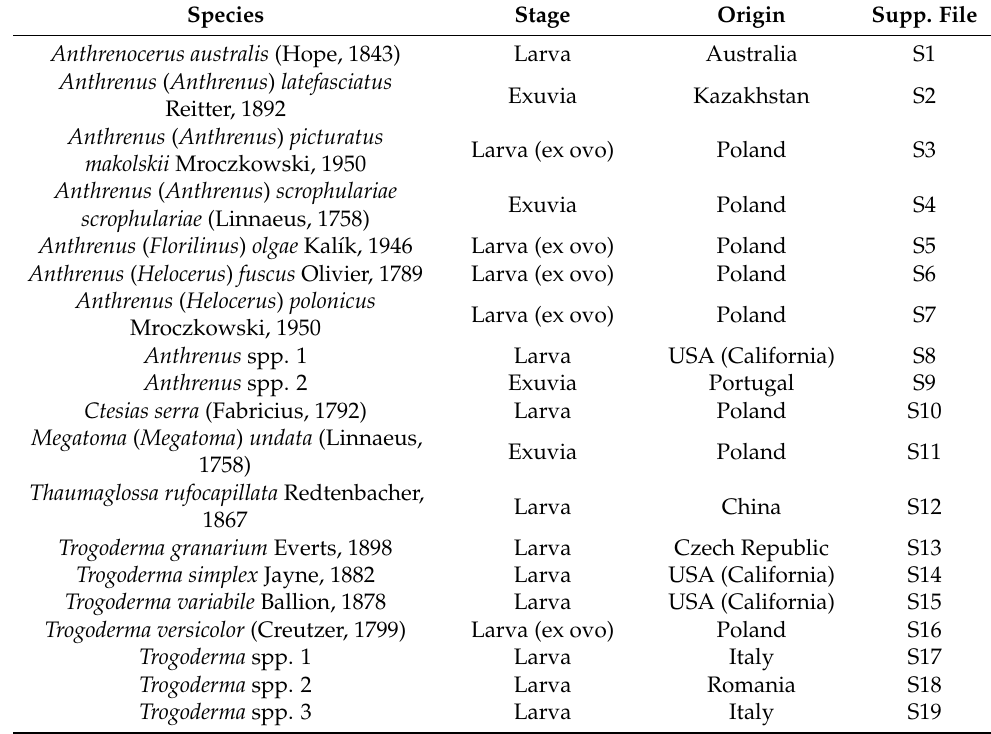
Table 1. List of the taxa included in the